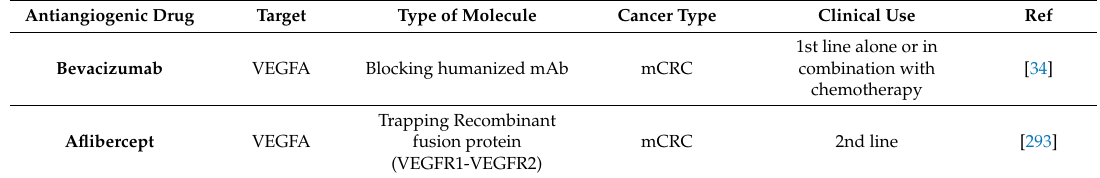
Table 1. Summary of the major drugs targeting ECs, currently used for the treatment of GI